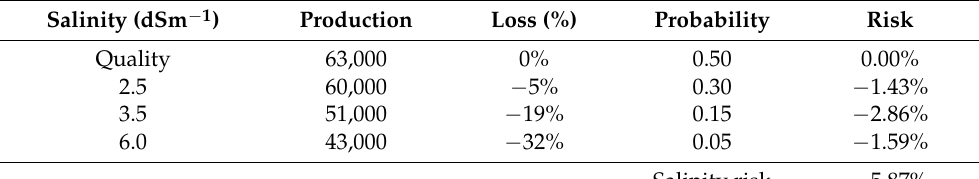
Table 5. Risk due to